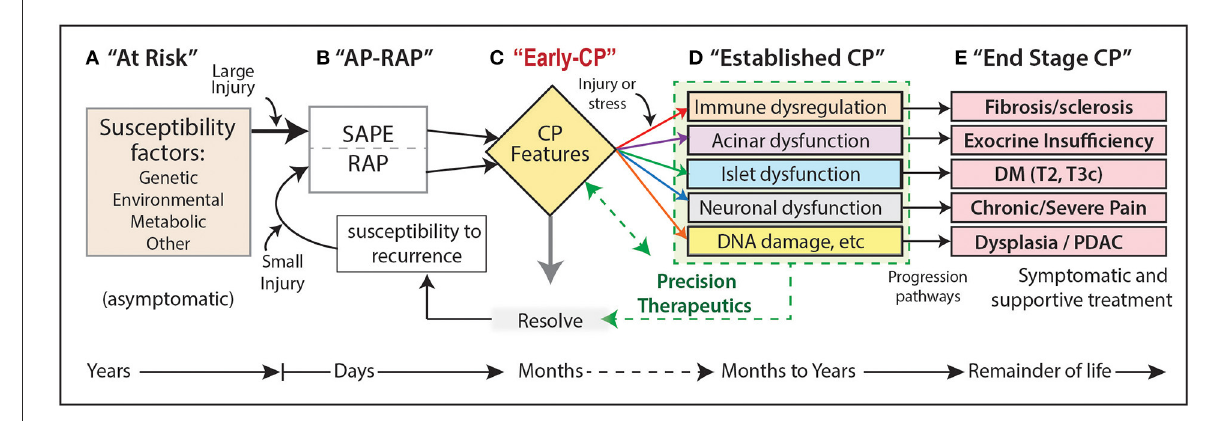
FIGURE1 (A–E) Progressive CP pathogenesis. Five progressive stages can be defined that persist for days to many years. Each stage may have unique risk factors or stress/injury mechanisms, as well as innate compensatory or protective mechanisms that may be altered or defective in patients who progress. Stage B is a critical driver of the CP pathways as the initial episode of AP (SAPE) lowers the threshold for RAP. CP, chronic pancreatitis; DM, diabetes mellitus; RAP, recurrent acute pancreatitis; SAPE, sentinel acute pancreatitis event; PDAC, pancreatic ductal adenocarcinoma;